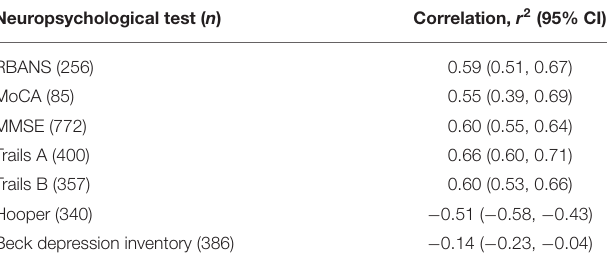
TABLE 3 | Correlation of DCTclock scores to standard neuropsychological test scores. Neuropsychological test ( n